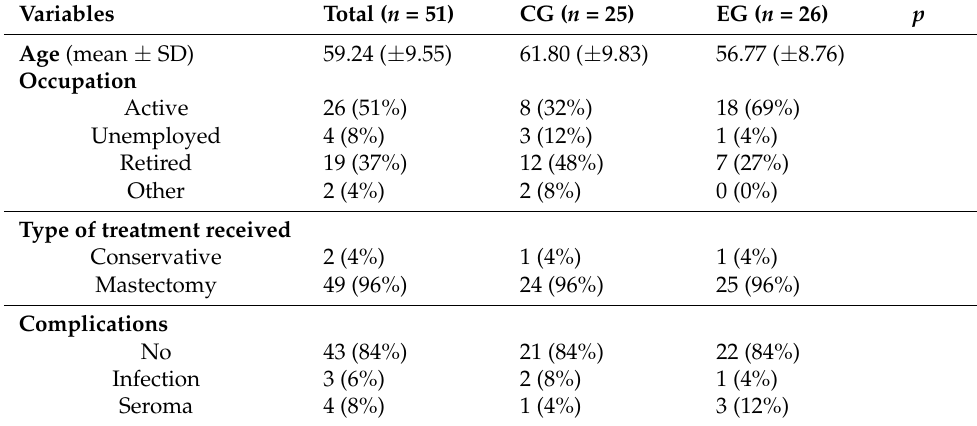
Table 1. Main characteristics of